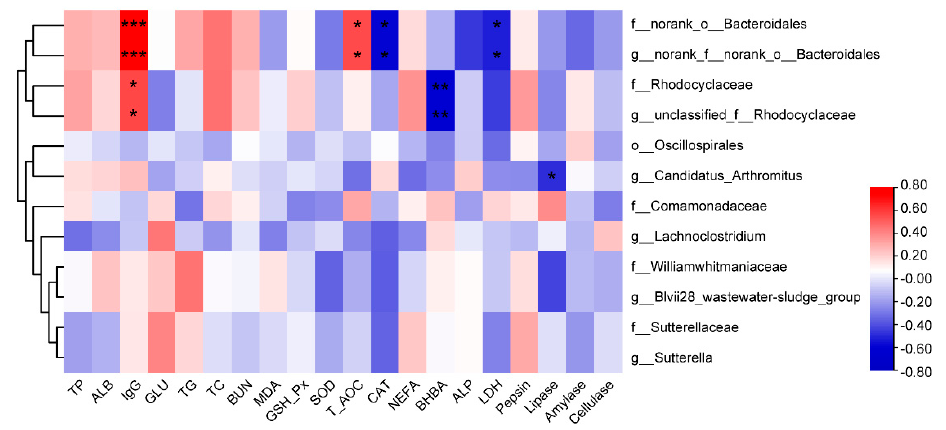
Figure 3. Correlation analysis between serum biochemical variables, rumen enzyme concentrations, and differential bacteria. The X and Y axes are environmental variables and species, respectively, and the r and p ‐ values were obtained by Spearman analysis. The r values are displayed in different colors. The right image is the color interval of different r values. * 0.01 < p ≤ 0.05, ** 0.001 < p ≤ 0.01, *** p ≤ 0.001.